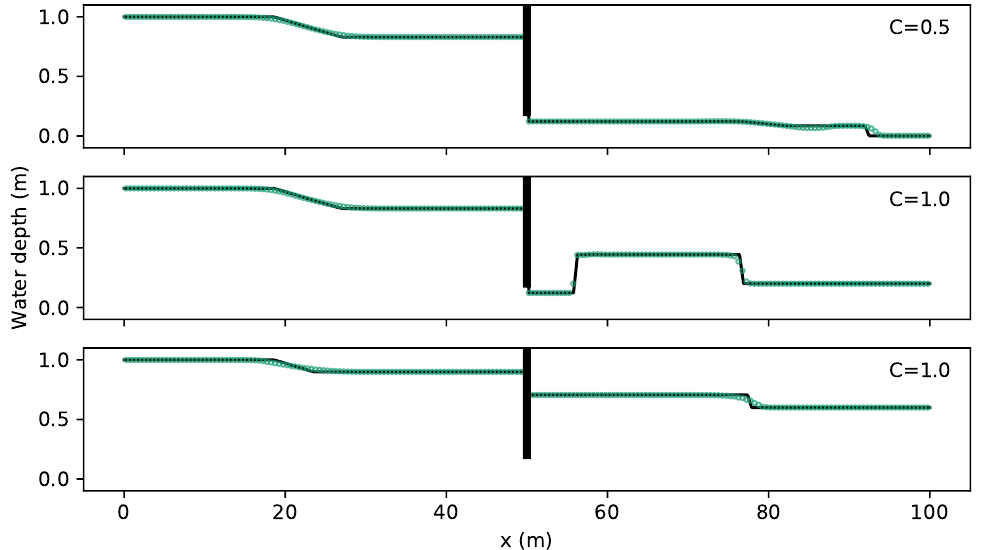
Figure 9. Analytical (black lines) and numerical (green circles) solutions for wet-bed Riemann problems at sluice gates, based on Tests 3–5 from [72] with C c = 0.61 and ∆ E =